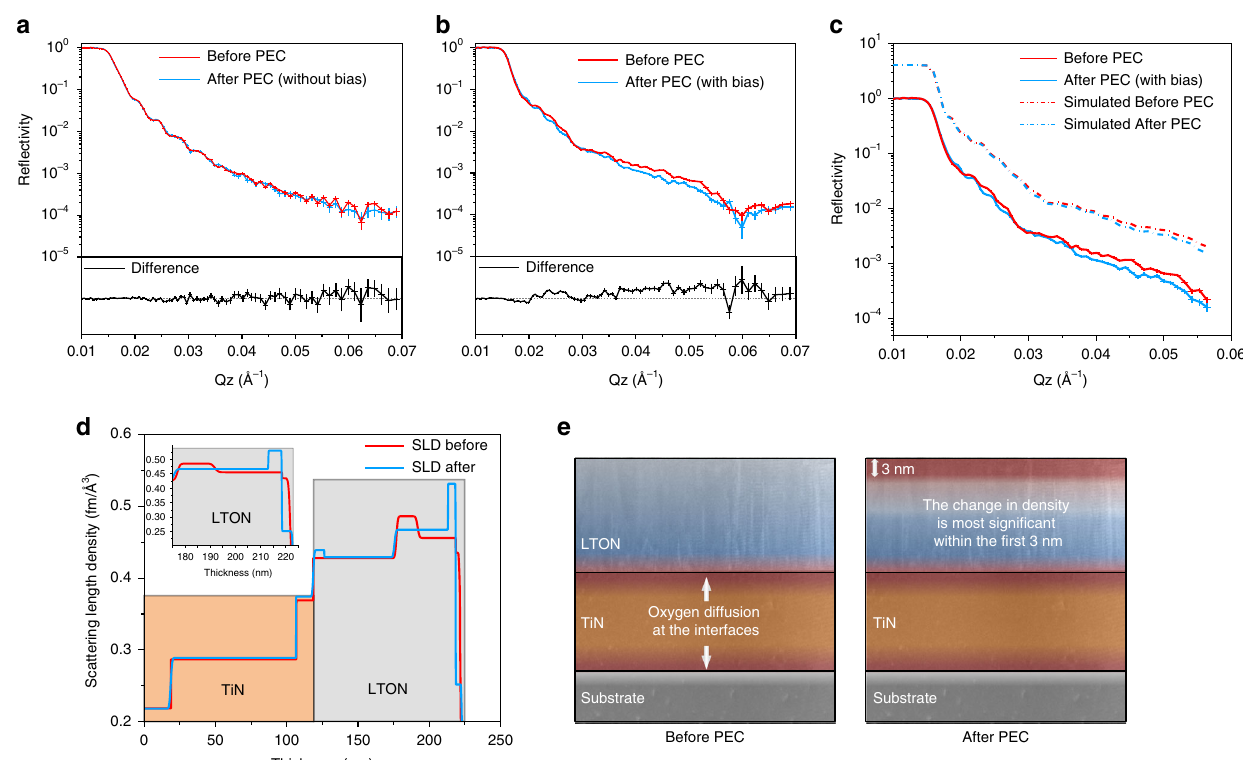
Fig. 4 Neutron re fl ectometry data for LTON thin fi lms. a Re fl ectivity plot for an LTON fi lm exposed to electrolyte and light intensity, yet no external bias was applied to the sample and showed no photoelectrochemical performance. b Re fl ectivity curve for LTON thin fi lm comparing before and after PEC measurements with applied bias. c Experimental and corresponding model fi t for data shown in ( b ), shown by the solid and dashed lines respectively. d The inferred scattering length density pro fi le as a function of depth from the corresponding fi t. The inset shows the magni fi ed region at and near to the surface of LTON. e Depth pro fi le of the samples before and after PEC, where the largest change in the SLD corresponds to a more oxidised surface layer of 3